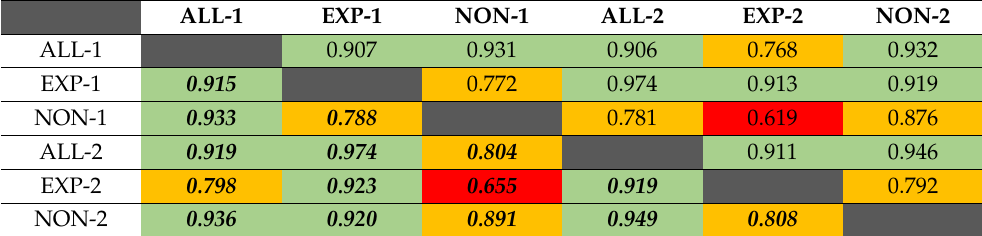
Table 7. Intraclass correlation coefficient for all groups of pathologists.